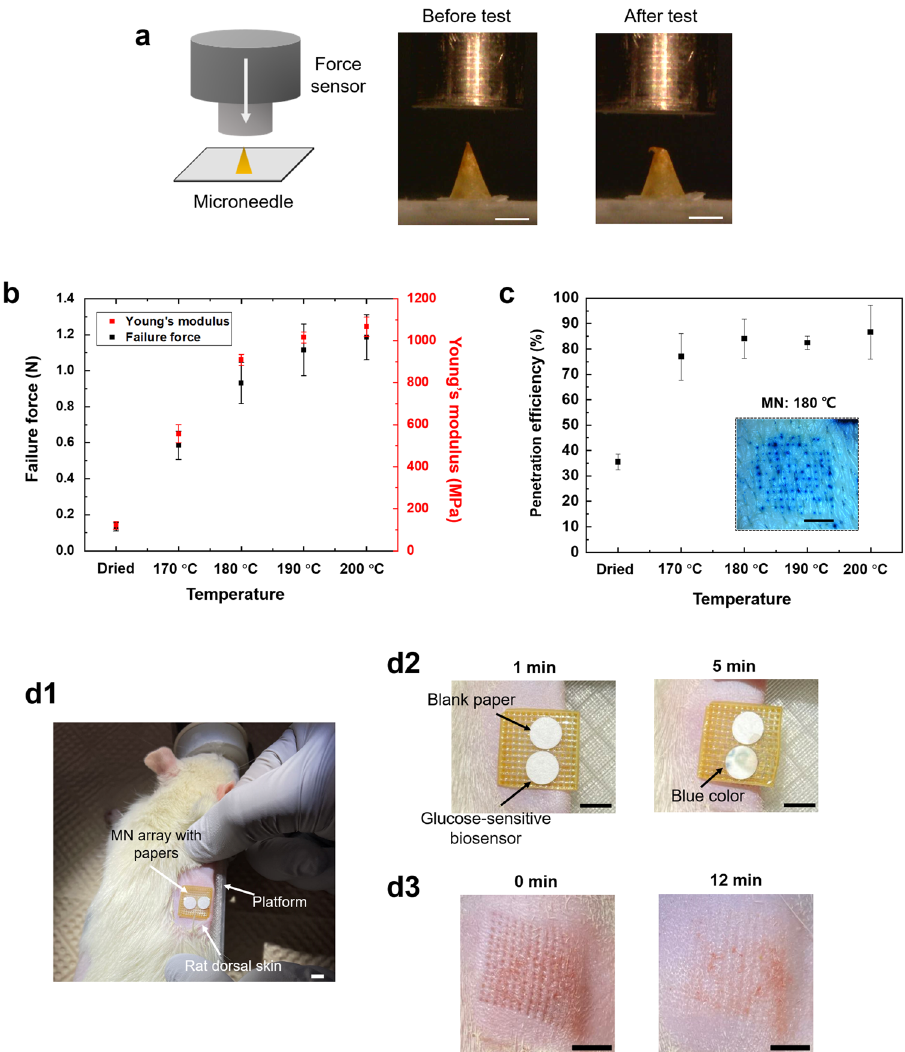
Figure 4. Evaluation of mechanical property and skin insertion of porous MNs. ( a ) A schematic of a mechanical compression test setup with axial moving force sensor and optical micrographs of porous MNs heat- treated at 180 °C before and after an axial failure test. Scale bar, 500 μm. ( b ) Failure force and calculated Young’s modulus of porous MNs after heat treatment at different temperatures. ( c ) Penetration efficiency of porous PLA MNs after heat treatment at different temperatures. Inset image shows the insertion of porous MNs after heat treatment at 180 °C into the porcine skin stained with methylene blue. Scale bar, 5 mm. ( d ) Rat skin insertion and ISF extraction using porous MNs attached with a glucose-sensitive paper and a blank paper. Rat dorsal skin was fixed onto a 3D-printed platform for MN insertion ( d1 ) and images indicated ISF extraction by porous MNs and move to the attached papers within 5 min ( d2 ) as well as recovery of the rat skin over time after removal of the MN array ( d3 ). Scale bar, 5